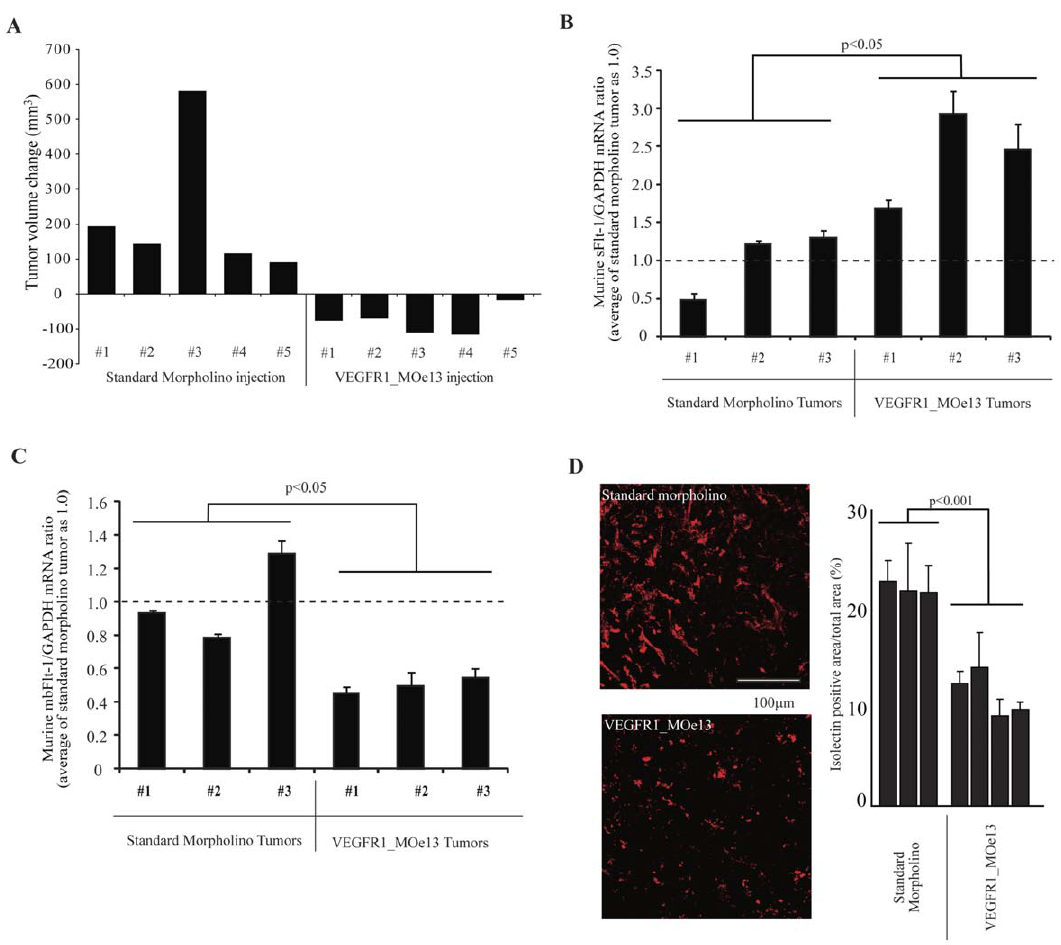
Figure 5. Intra-tumoral VEGFR1_MOe13 injection results in regression of established MBA-MD-231 human breast adenocarcinoma xenograft tumors and decreased tumor vascularity. a. MB-MDA-231 breast cancer cells were grown as xenografts in female nude mice for 2 weeks prior to beginning treatment with either a standard morpholino or VEGFR1_MOe13 designed to target the murine VEGFR1 transcript. Morpholino treated tumors demonstrate size regression after a 4 week treatment course as demonstrated by volume change analysis of 5 individual tumors within each treatment condition. p=0.04 b–c. Following treatment course, RNA was extracted from xenograft tumors and soluble or membrane bound Flt1 levels were measured using real-time RT-PCR. Error bars indicate variation between individual PCR reactions per tumor sample. d. Following the treatment course, VEGFR1_MOe13 or standard morpholino xenograft tumors were sectioned and stained with isolectin as a measure of vascularity. Individual bars represent sections analyzed thoughout each tumor